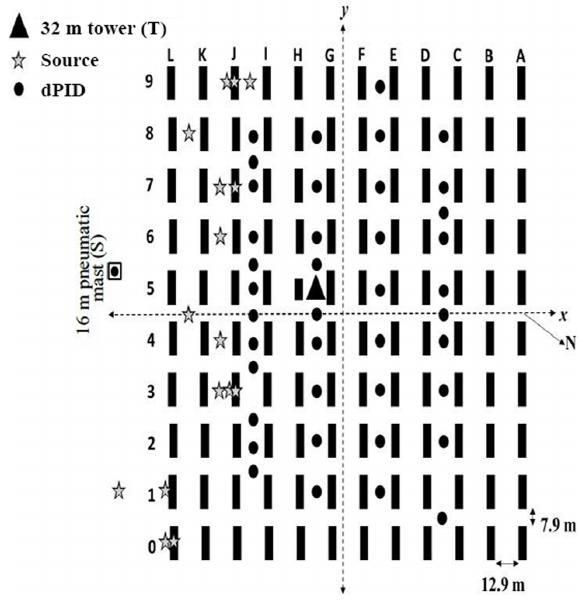
Figure 1. A schematic diagram of the MUST geometry showing 120 containers and source (stars) and receptor (black filled circles) locations. In a given trial only one source was